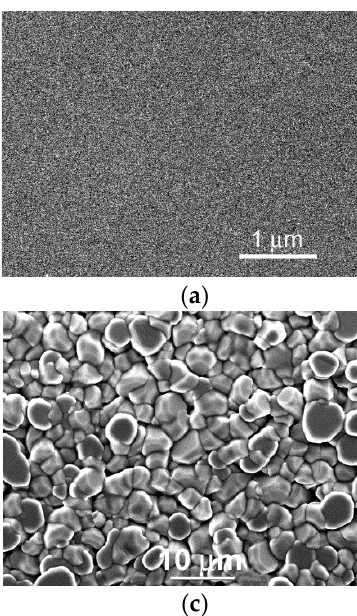
Figure 3. Electron microscope imagines of ZnO films deposited on the different substrates: ( a ) silicon; ( b ) ITO glass; ( c ) sapphire; ( d ) Kapton (polyimide).